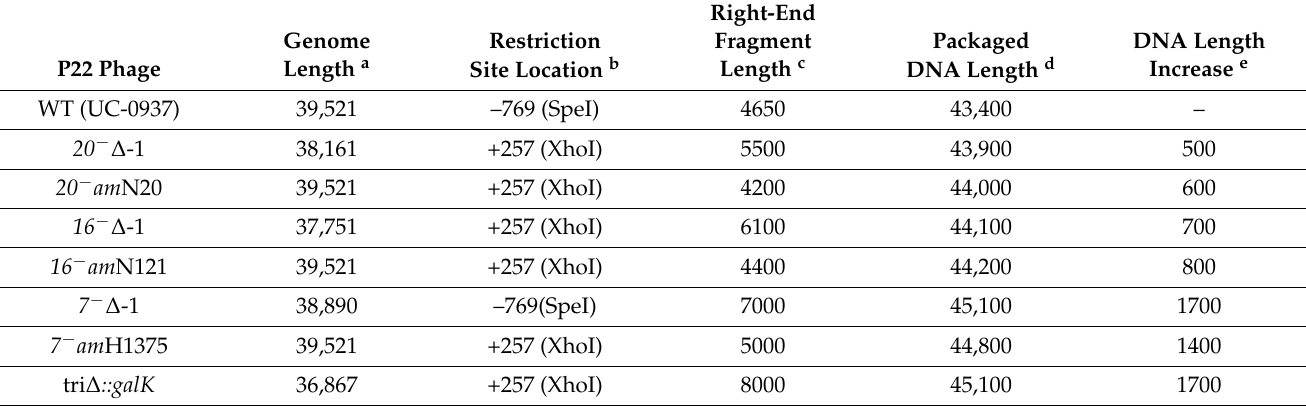
a. Arrow A (genome) length in Figure 1. The bp lengths of the virion chromosomes of P22 UC-0937 and the four deletion phages were confirmed by Illumina whole genome sequencing. The amber mutant phage genomes have the same length as P22 UC-0937. b. Arrow B length in Figure 1. The restriction enzyme used was chosen to position the right-end fragment in the gel for optimum size measurement. c. Arrow C (right end fragment) length in Figure 1. Values are the average of three or more determinations of the average length and of the right-end restriction fragments (center of fuzzy gel band). The range of values obtained indicated that the accuracy of this measurement was about ± 100 bp when fragments are in the 2–5 kbp range and ± 200–300 bp for larger sizes. d. Length of DNA packaged is the sum of the lengths of arrows A + B + C in Figure 1 (see text). e. Increase in length of mutant packaged DNA over the isogenic P22 UC-937 parent that has all three E-proteins in